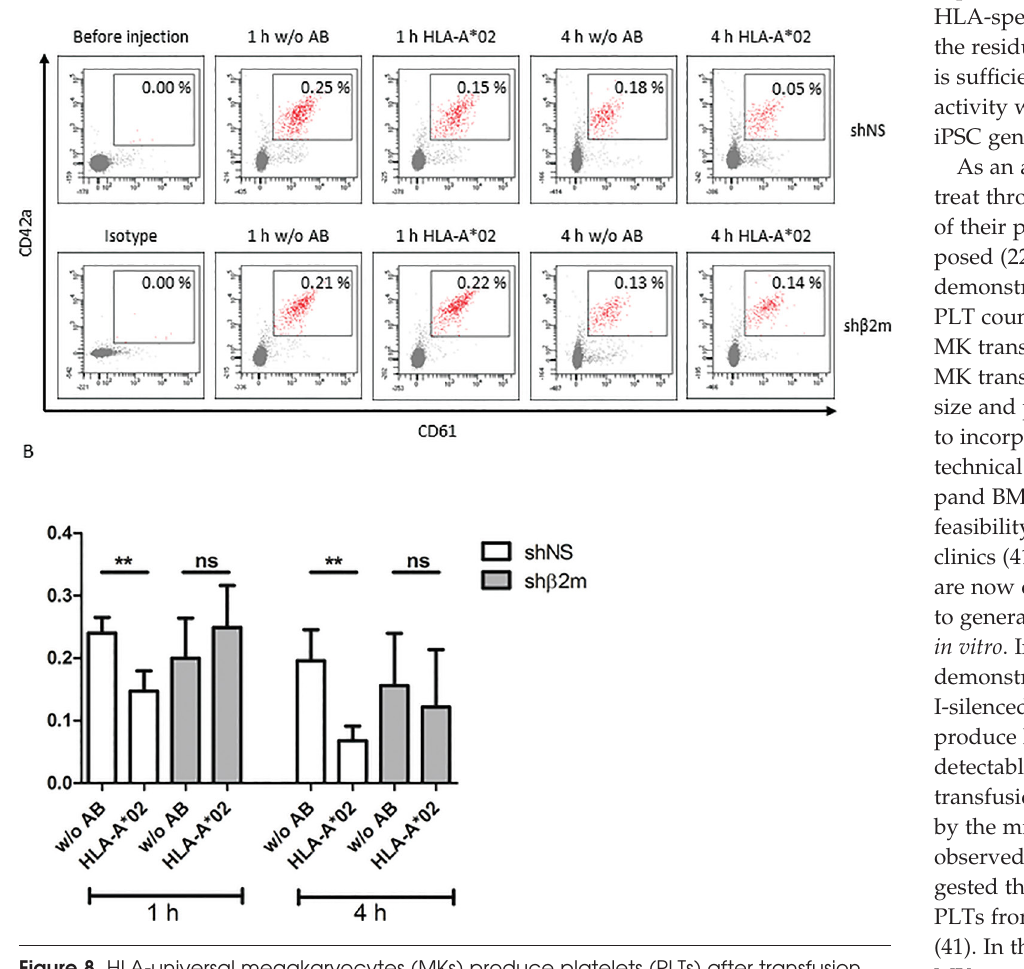
Figure 8. HLA-universal megakaryocytes (MKs) produce platelets (PLTs) after transfusion into a mouse model. Mice were transfused with 3 × 10 6 HLA-universal iPSC-derived MKs by tail vein injection. Twenty minutes before transfusion of MKs, the mice get immunized by injection of anti-HLA-A*02 antibody. Nonimmunized mice served as a control. Frequen- cies of human PLTs were detected before transfusion as well as 1 and 4 h after MK infu- sion by flow cytometric analysis of the PB. (A) Representative dot plots displaying human PLTs detected in the mouse circulation. The gate indicates the frequency of human PLTs. (B) The graph shows mean and SD of the PLT frequencies detected after HLA-universal MK transfusion in three independent experiments. ** p ≤